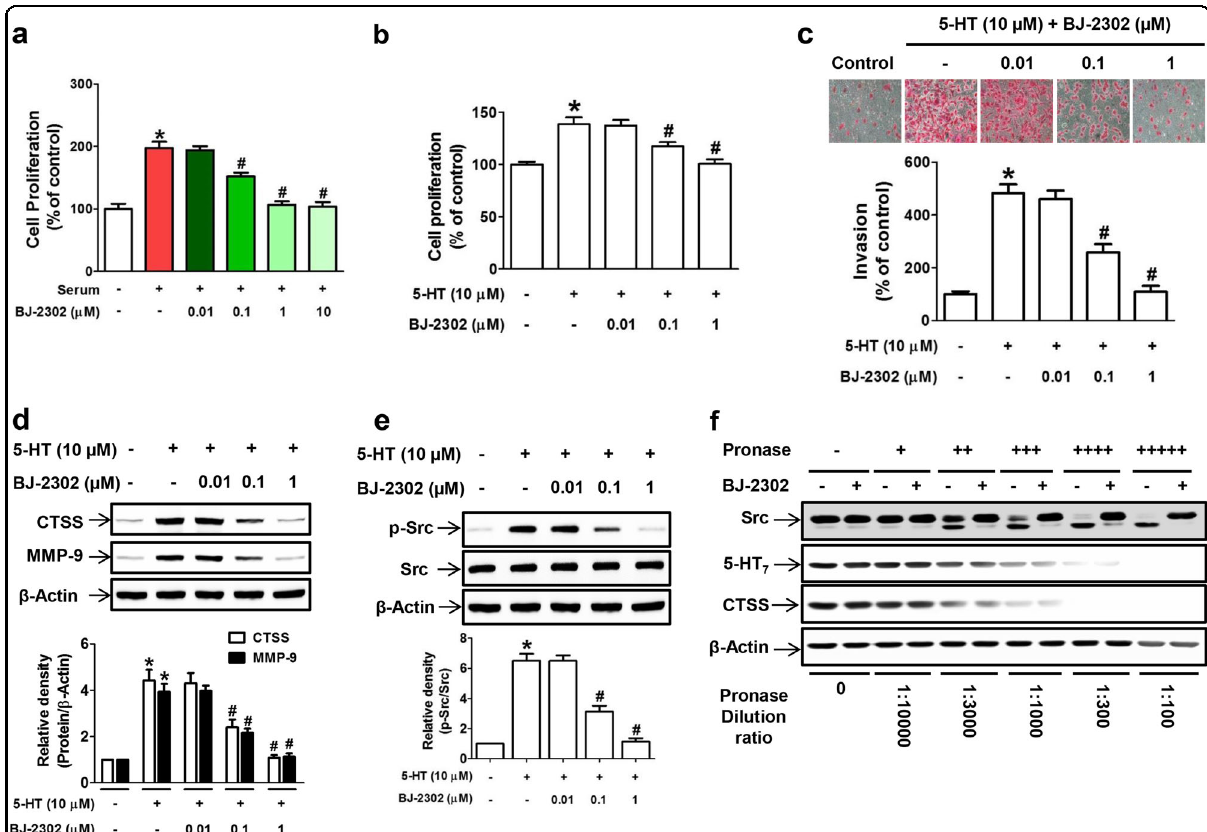
Fig. 6 Suppression of TNBC cell progression by BJ-2302. a , b MDA-MB-231 cell proliferation induced by serum ( a ) or 5-HT ( b ) was measured in the presence of BJ-2302. c 5-HT-induced MDA-MB-231 cell invasion, d , e 5-HT-induced protein expression of CTSS and MMP-9 ( d ) and phosphorylation of Src ( e ) were suppressed by BJ-2302. The bar graphs represent the mean ± S.E.M. from three independent experiments * P < 0.05 compared to vehicle-treated cells. # P < 0.05 compared to serum- or 5-HT-treated cells. f DARTS assay showing direct binding of BJ-2302 to Src but not to the 5-HT 7 receptor or CTSS protein. The bands are representative of three independent